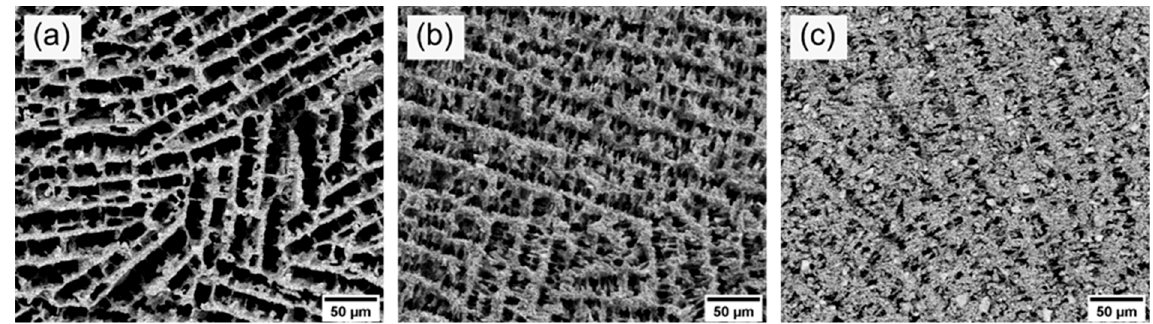
Figure 7. SEM images of the axial cross-section of samples 10Y ( a ), 15Y ( b ), and 20Y ( c ) after thermal aging at 1400 °C for 96 h.